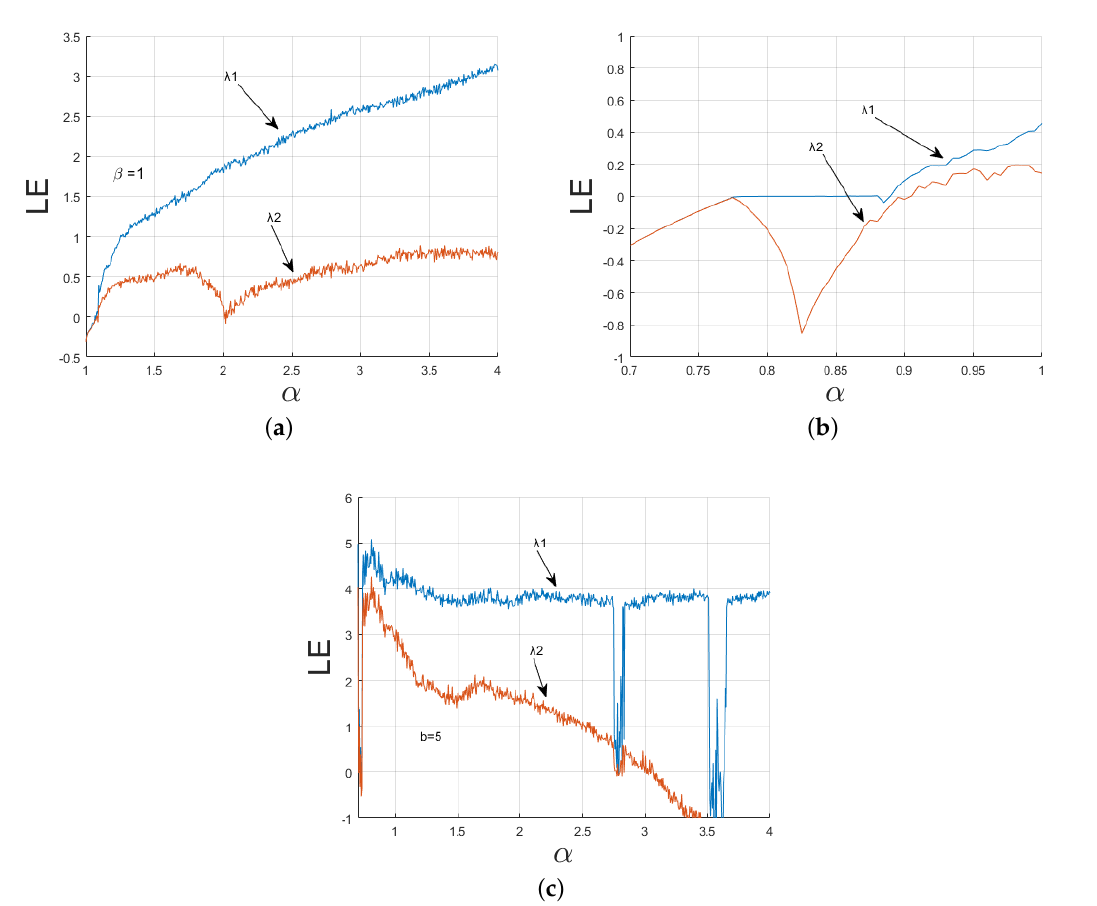
Figure 3. Lyapunov exponents of ( a ) FL-NMLD, β = 0.8, ( b ) 2D-SLMM, and ( c ) 2D-SIMM, b =